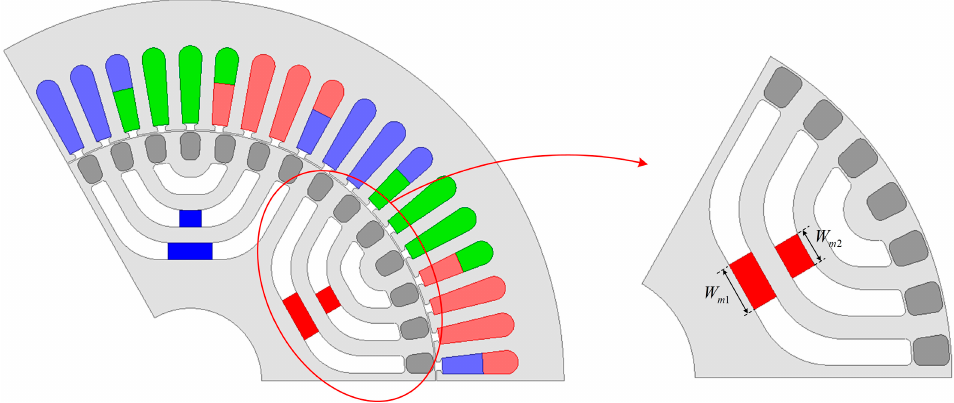
Figure 11. Parameter for analysis of the characteristic according to length of magnet.